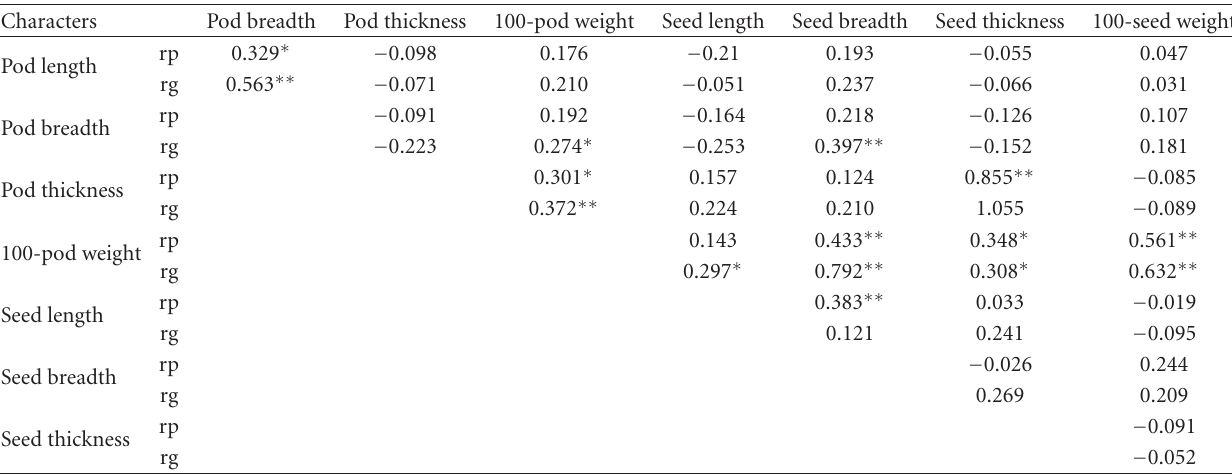
Table 5: Phenotypic (rp) and genotypic (rg) correlation coe ffi cients between di ff erent pod and seed characters of P. pinnata